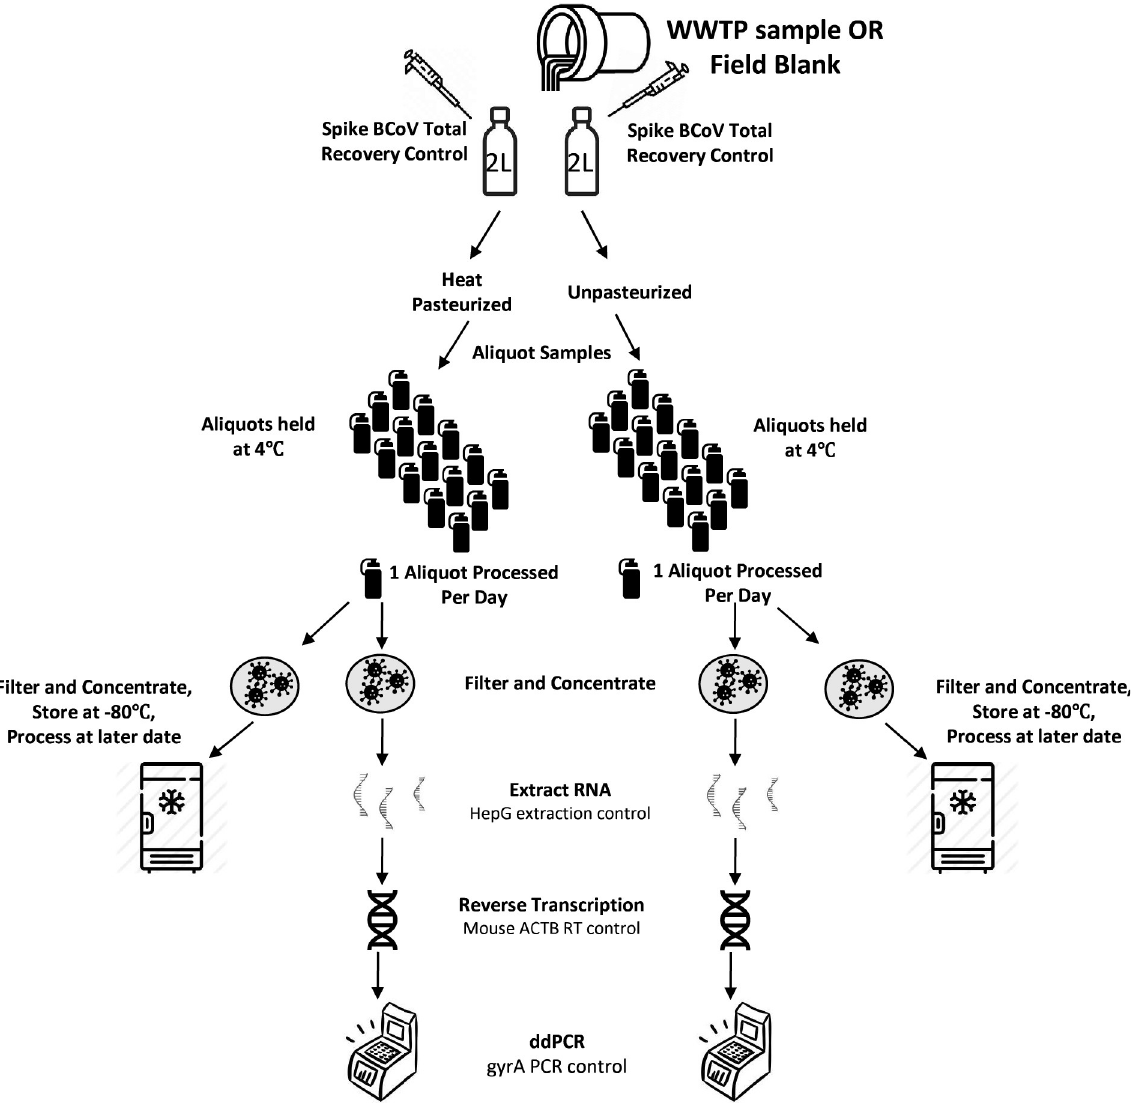
Fig 1. Overview of sample collection and processing with controls for each step